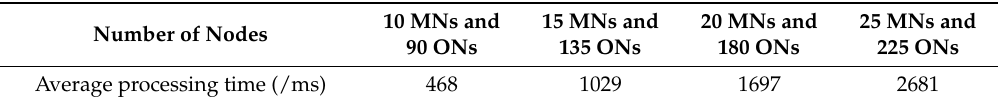
Table 1. Average processing time of ORAGC with 500 rounds by increasing the number of nodes in the